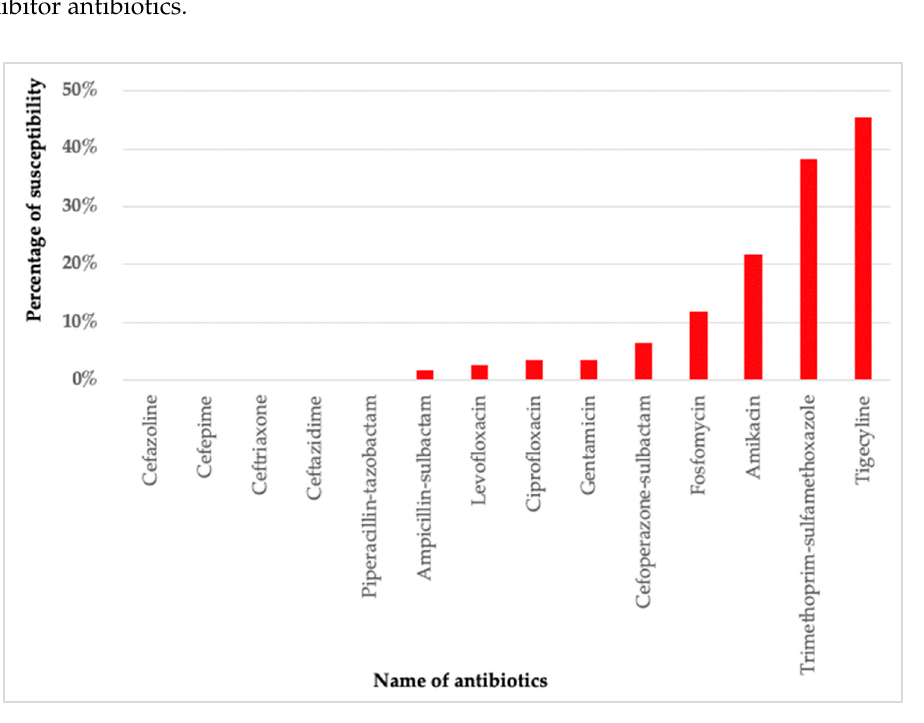
Figure 2. Antibiotic resistance test of CNSAB isolates from bacteremia patients in Indonesia ( n =